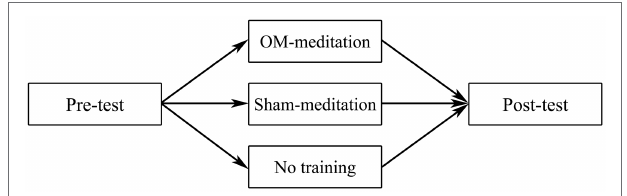
FIGURE 1 | The experimental plan.